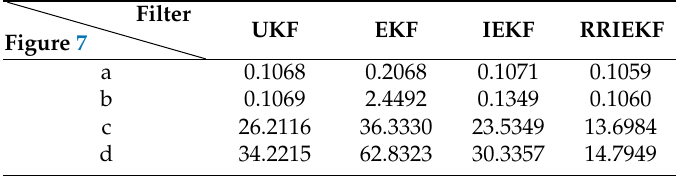
Table 6. RMSE Position Errors.